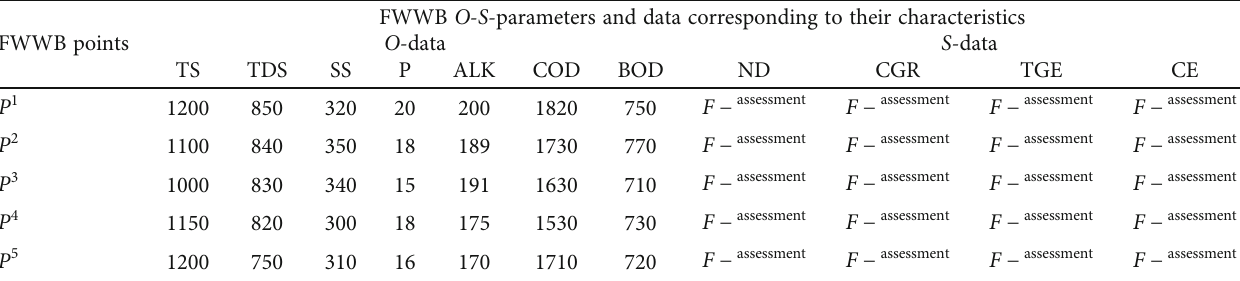
Table 2: FWWB O - S -parameters and corresponding data.